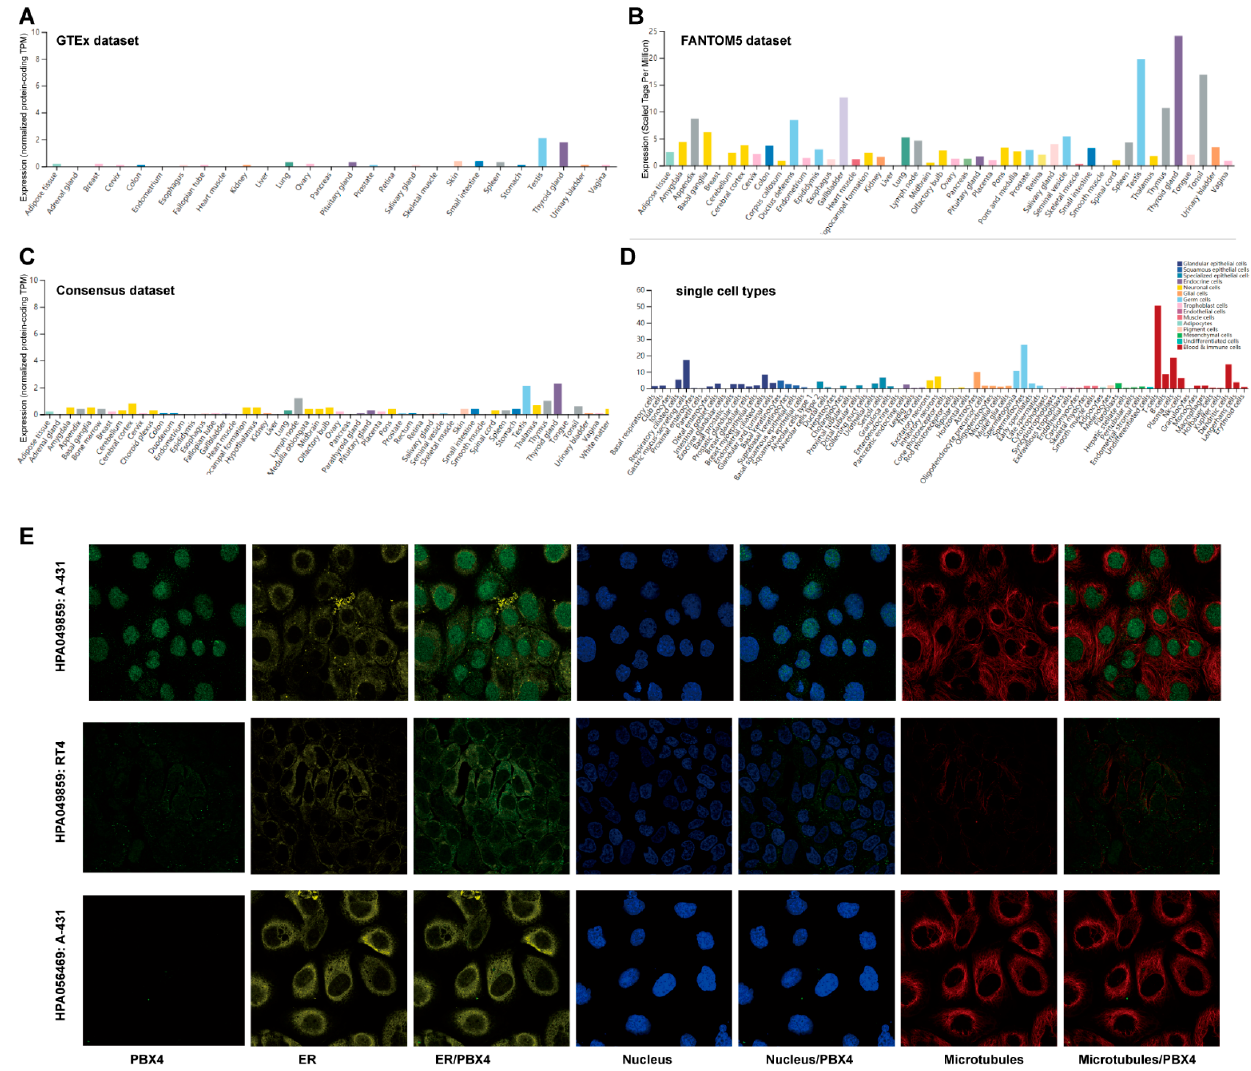
Figure 2. The expression levels of PBX4 in normal human tissues and its localization. ( A ) The mRNA expression of PBX4 in different human tissues from the GTEx dataset. ( B ) The mRNA expression of PBX4 in different human tissues from the FANTOM5 dataset. ( C ) The mRNA expression of PBX4 in different human tissues from the Consensus dataset. ( D ) Overview of PBX4 expression from all single cell types. ( E ) Immunofluorescence staining of the subcellular localization of PBX4 in the endoplasmic reticulum (ER), nucleus, and microtubules of A-431 (#HPA056469), RT4 (#HPA049859), and A-431 (#HPA049859) obtained from the HPA database.